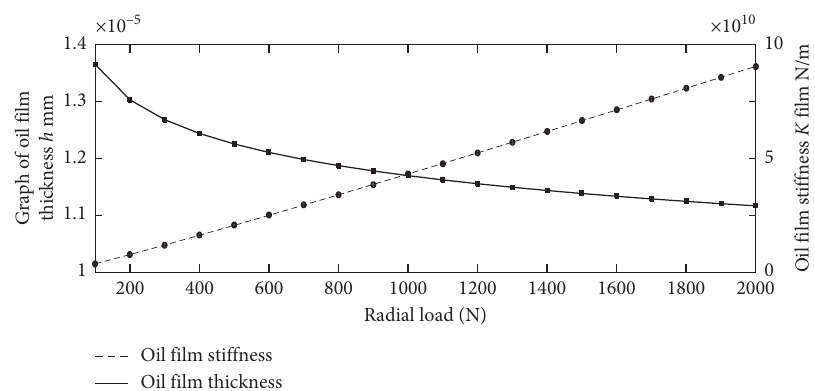
Figure 7: Changes of oil film thickness and stiffness under different loads.